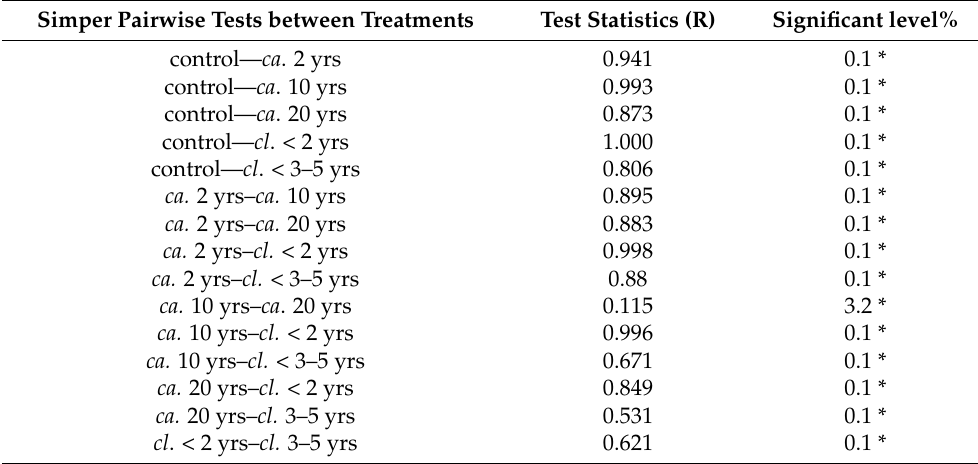
Table 2. Simper pairwise comparison test between the six treatments inside the Groenkloof Nature Reserve, South Africa. Significant values are indicated by an asterisk.